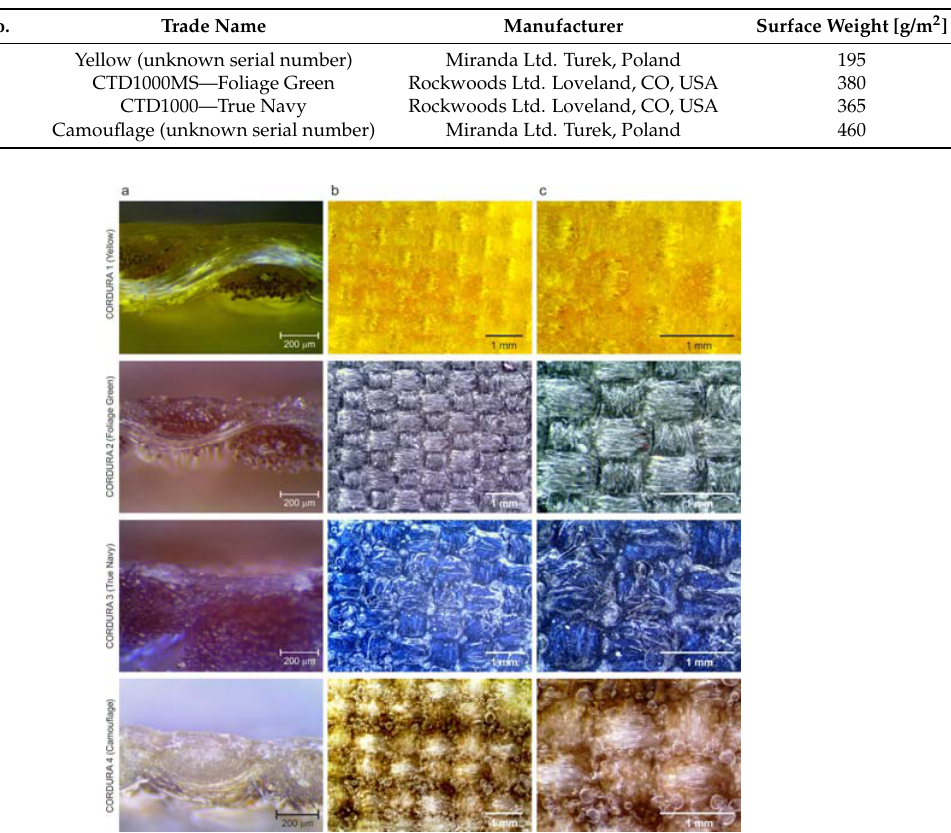
Figure 2. Cross-sections ( a ) and surfaces ( b , c ) of examined Cordura materials visible under a Delta Optical SZ–630T bright-field microscope; images obtained using × 100, × 20 and × 40 magnifying lenses